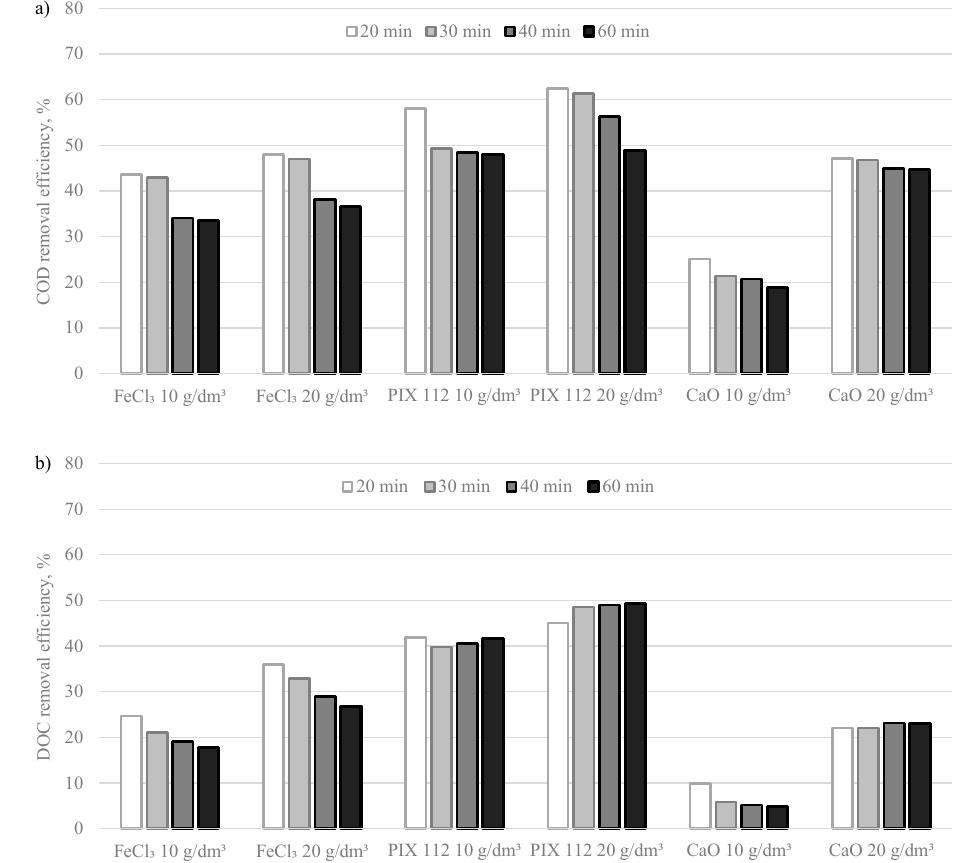
Figure 2. Influence of slow mixing time on COD ( a ) and DOC ( b ) removal efficiency for FeCl 3 ·6H 2 O, PIX 112, and CaO.